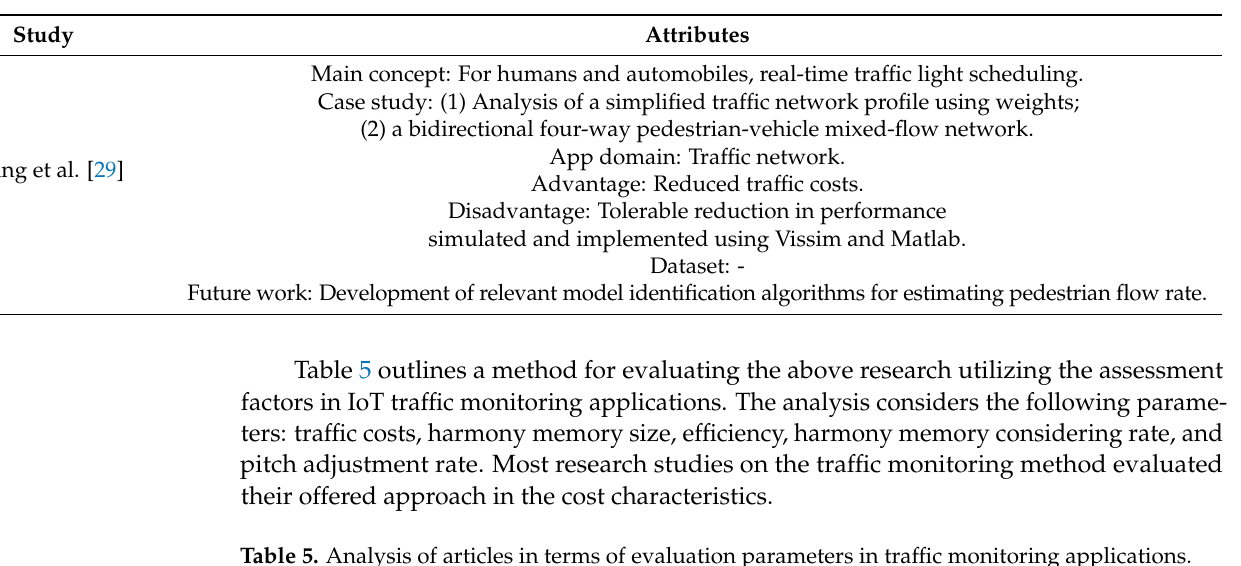
Table 4. Categorizing the state-of-the-art in Traffic Monitoring applications.